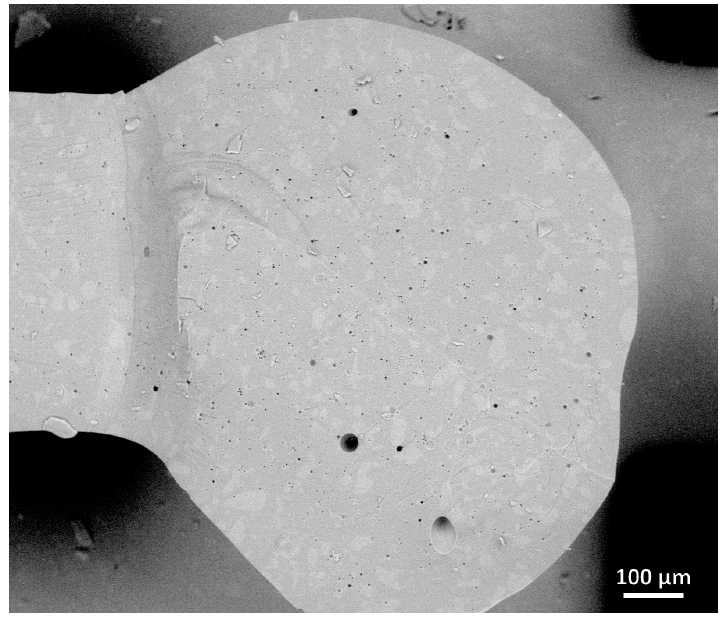
Figure 9. Scanning electron micrograph (backscattered electron image) of fractured wurtzite scaf ‐ fold.